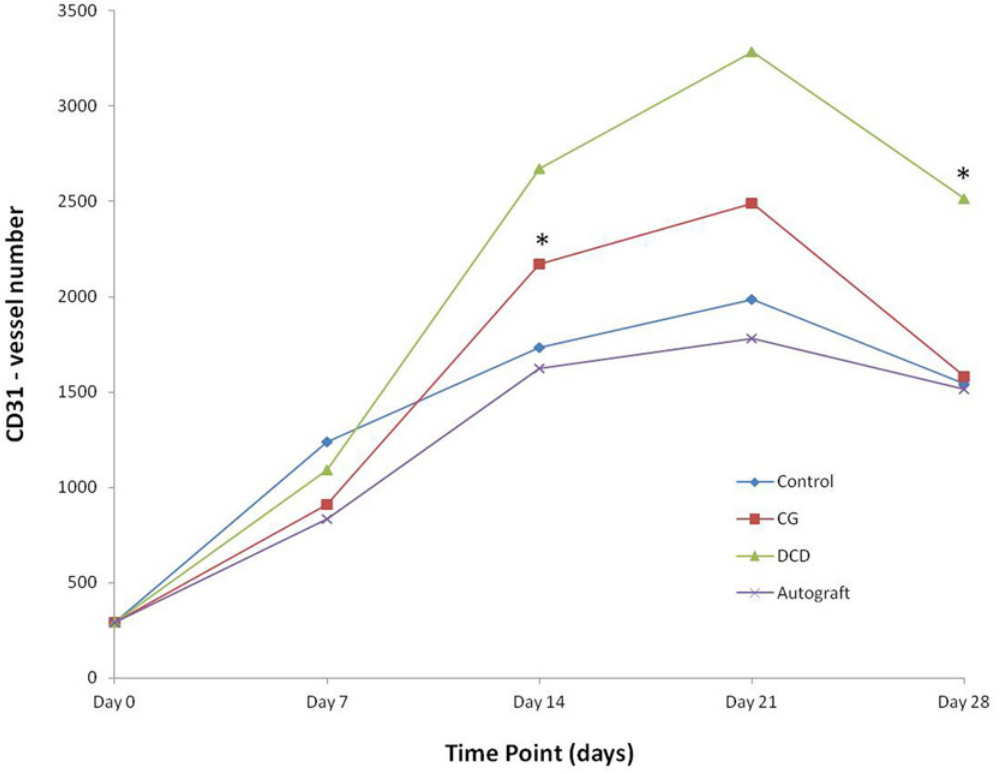
Figure 7. Immunohistochemical staining for endothelial cell marker CD31. Alterations in CD31staining enabling calculation of vessel number after injury which was significantly greater in DCD after 28 days (C) (n = 10/treatment group). * p <